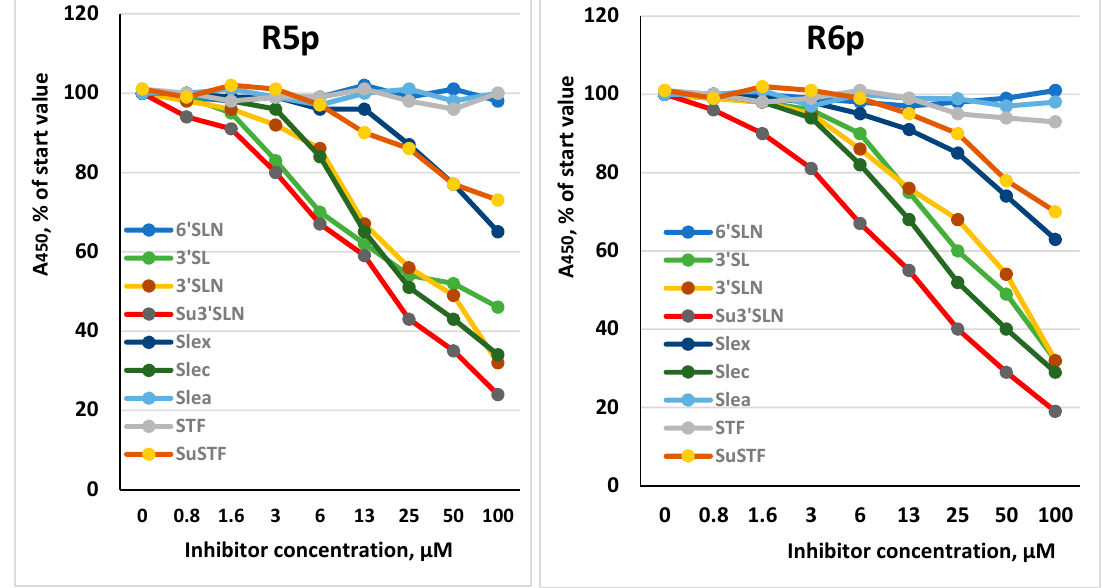
Figure 6. Inhibition of labeled fetuin binding to R5p and R6p viruses by the receptor analogs. Receptor analogs were added to a solution of labeled fetuin at the indicated concentrations and the level of binding of the label to the virus was measured. Result of a typical experiment is presented.